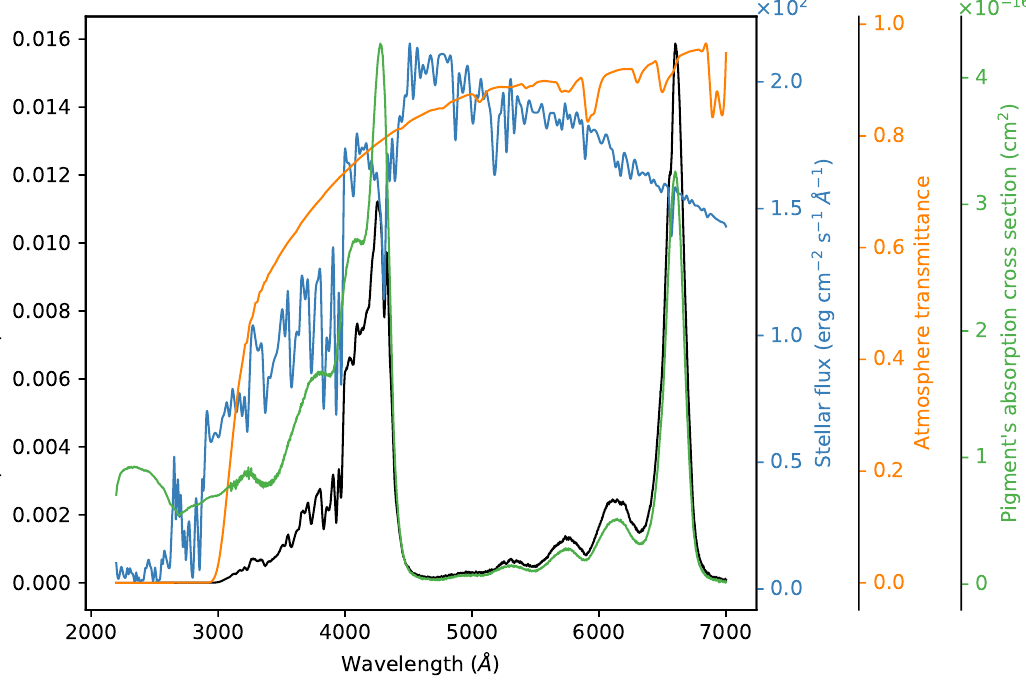
Figure 1. Example of spectral absorption rate calculation: Stellar flux F λ from a Sun-like star (G2V) at the top of the planet atmosphere (blue), transmittance ( T ) of an Earth-like atmosphere (orange), absorption cross section σ abs of chlorophyll a (green), and spectral absorption rate Γ λ from the combination of the three previous elements